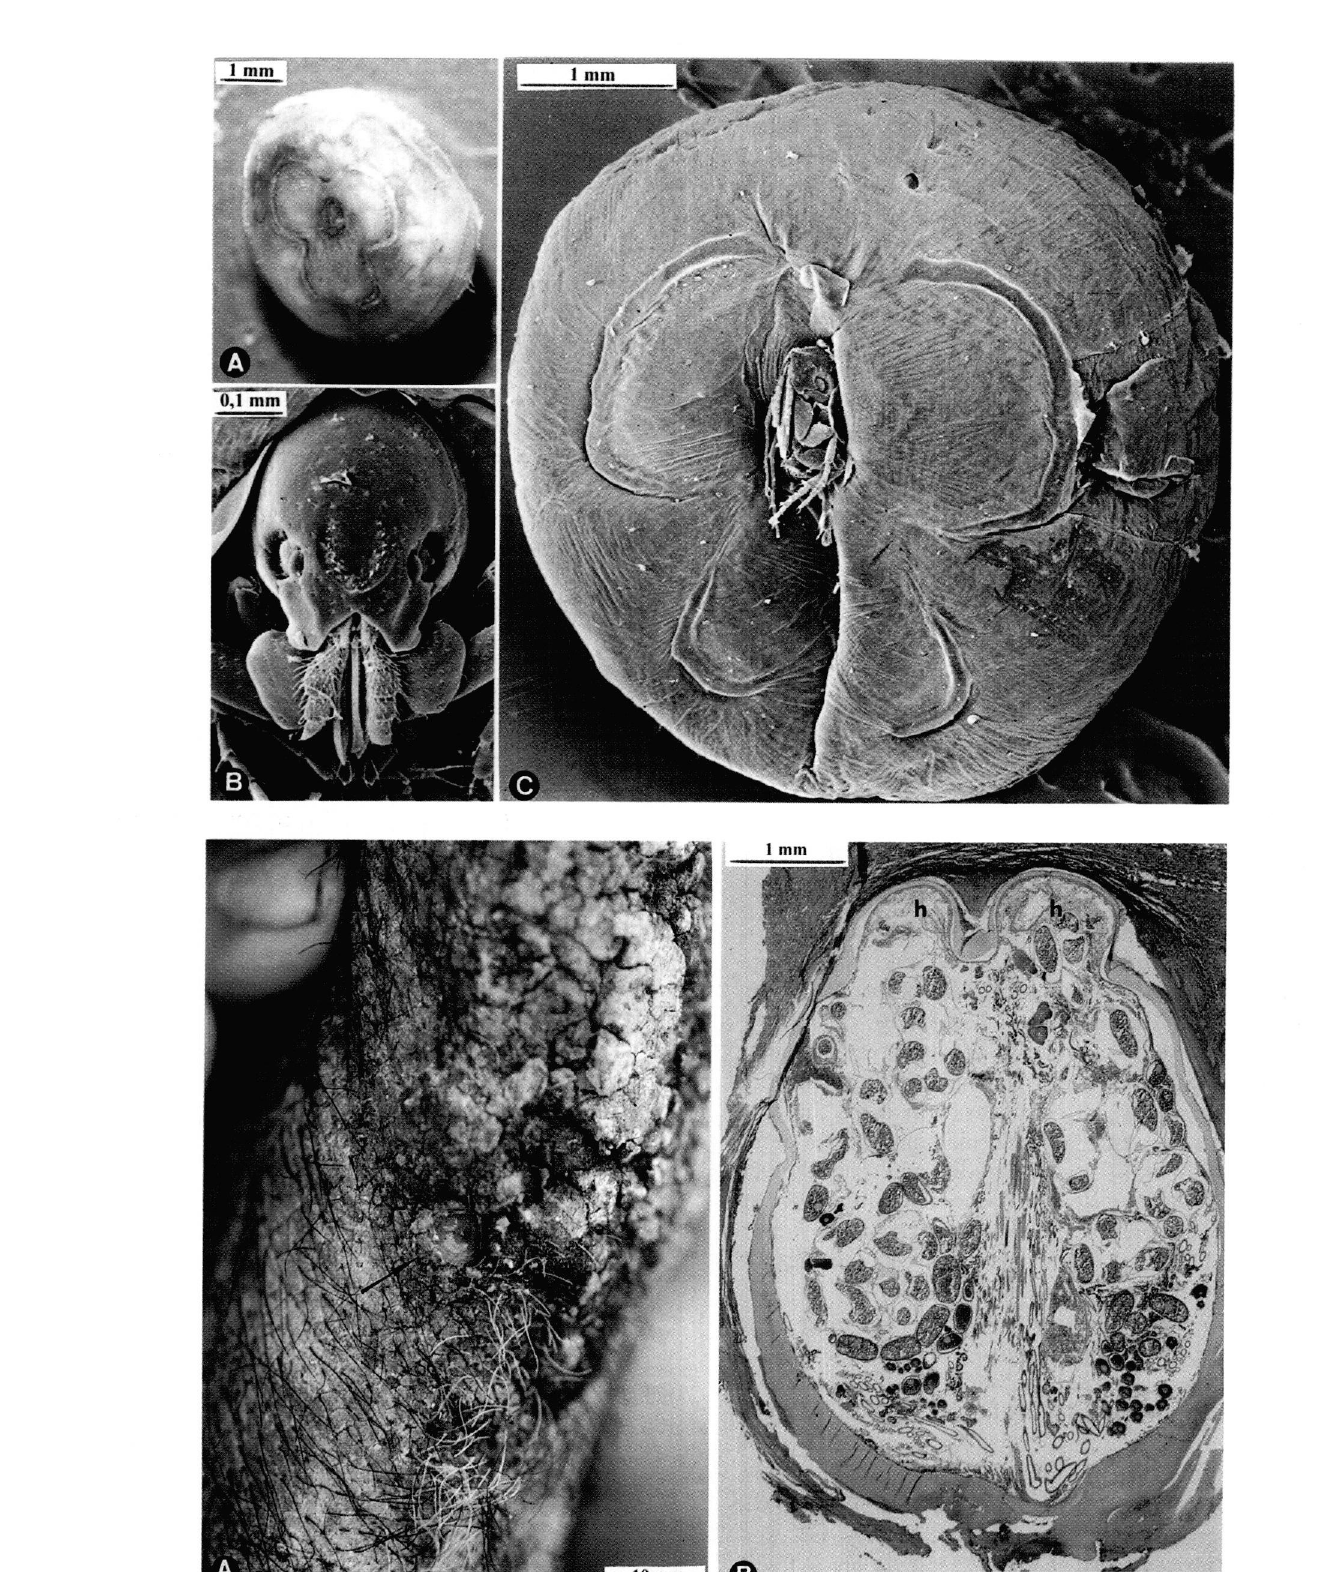
Fig. 3. - Tunga penetrans from human, Madagascar. (A) Gravid female. (B) Frontal view of head and thorax of gravid female, SEM. (C) Ante­ rior extremity of a gravid female, SEM. Fig. 4. - (A) Lesion due to Tunga trimamillata from pig. (B) Histological section of gravid female of Tunga trimamillata embedded in skin of a bovine (Trichromic Masson Goldner Stain). Note the humps (h).